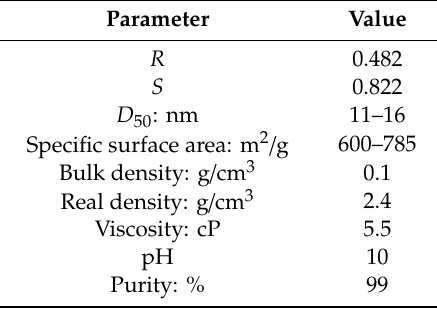
Table 2. Grading, packing, chemical and shape parameters for colloidal NS and silica